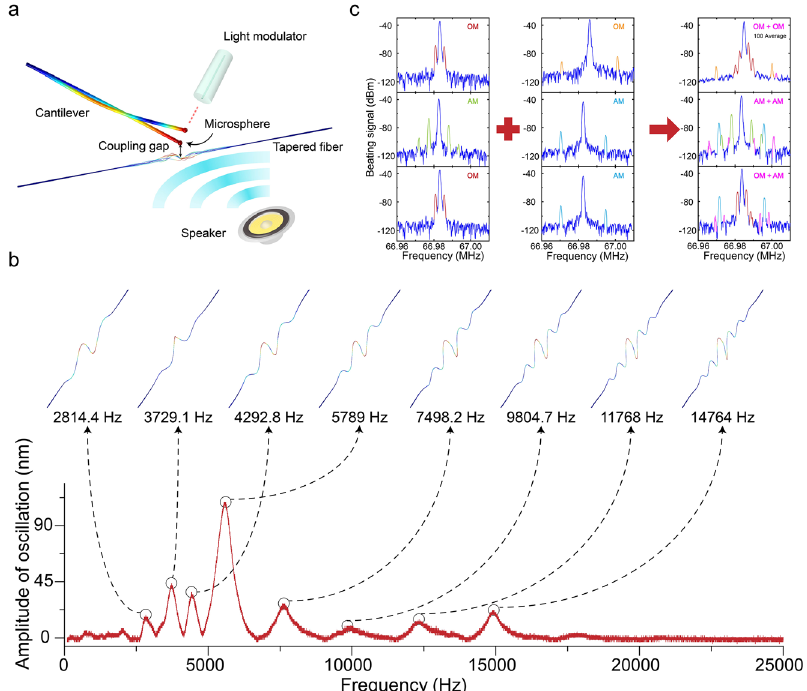
6.2 mm. Tapered fiber length: 52 mm. (b) Oscillation spectrum of